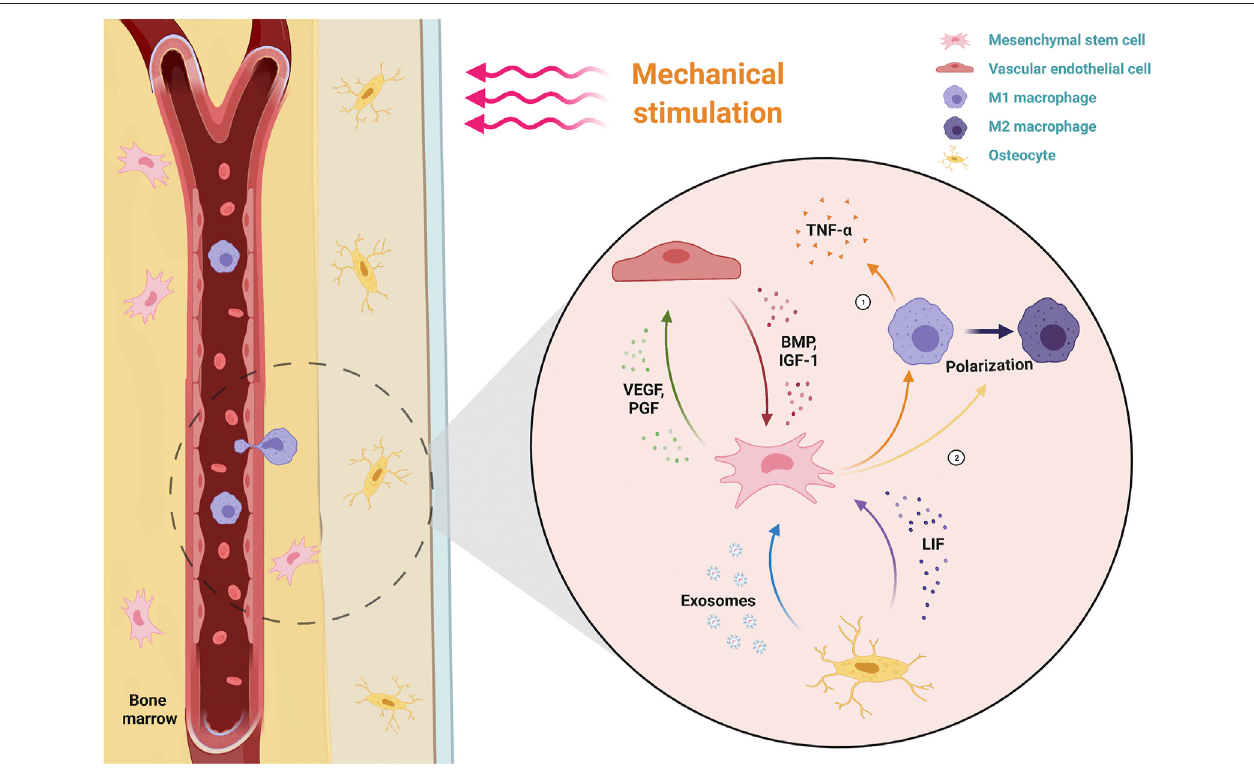
FIGURE2| DynamicinteractionsofMSCswiththeir microenvironmentunder mechanicalstimulation.MSCsperceivethemechanicalstimulationappliedtothe bone, which downregulates the in fl ammatory response by decreasing macrophage secretion of pro-in fl ammatory TNF- α and promoting the polarization of M1 macrophages (pro-in fl ammatory type) to M2 macrophages (anti-in fl ammatory type). Simultaneously, MSCs promote VEC angiogenesis by secreting angiogenic factors (VEGF, PGF). Osteogenic factors (BMP, IGF-1) secreted by mechanical activated-VECs, as well as LIF and exosomes secreted by mechanical activated-osteocytes, together promote the osteogenic differentiation of MSCs. TNF- α , tumor necrosis factor alpha; VECs, vascular endothelial cells; VEGF, vascular endothelial growth factor; PlGF, placental growth factor; BMP, bone morphogenetic protein; IGF-1, insulin-like growth factor 1; LIF, leukemia inhibitory